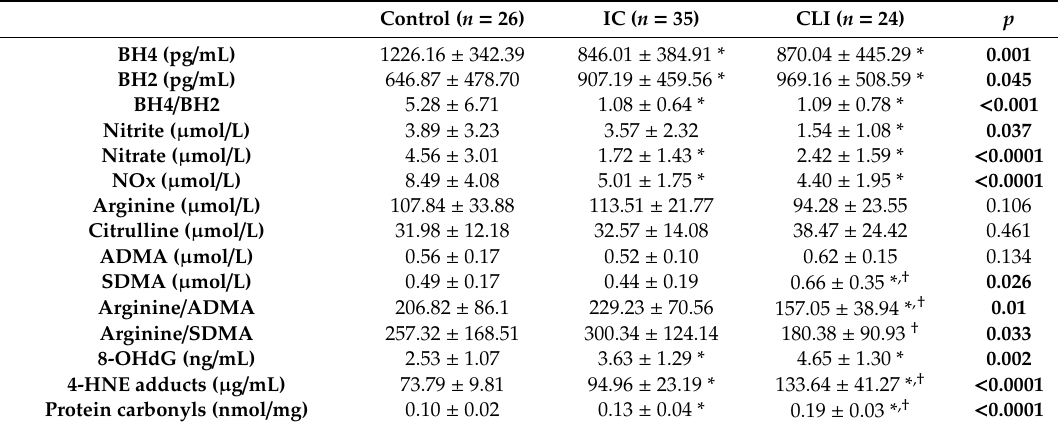
Table A1. Concentrations of nitric oxide bioavailability, nitric oxide synthesis regulators, and oxidative stress